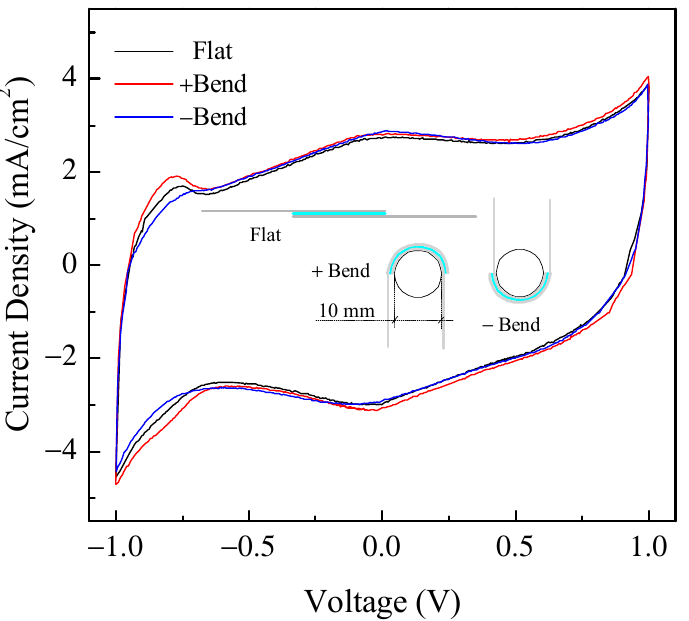
Figure 15. Comparison between current–voltage cycles of the same typical Au/PPy- GNP:DBSA/Nafion:LiPs/PPy-GNP:DBSA/Au cell measured in flat conditions and mounted into the sample holder in Figure 16a with two opposite curvatures.